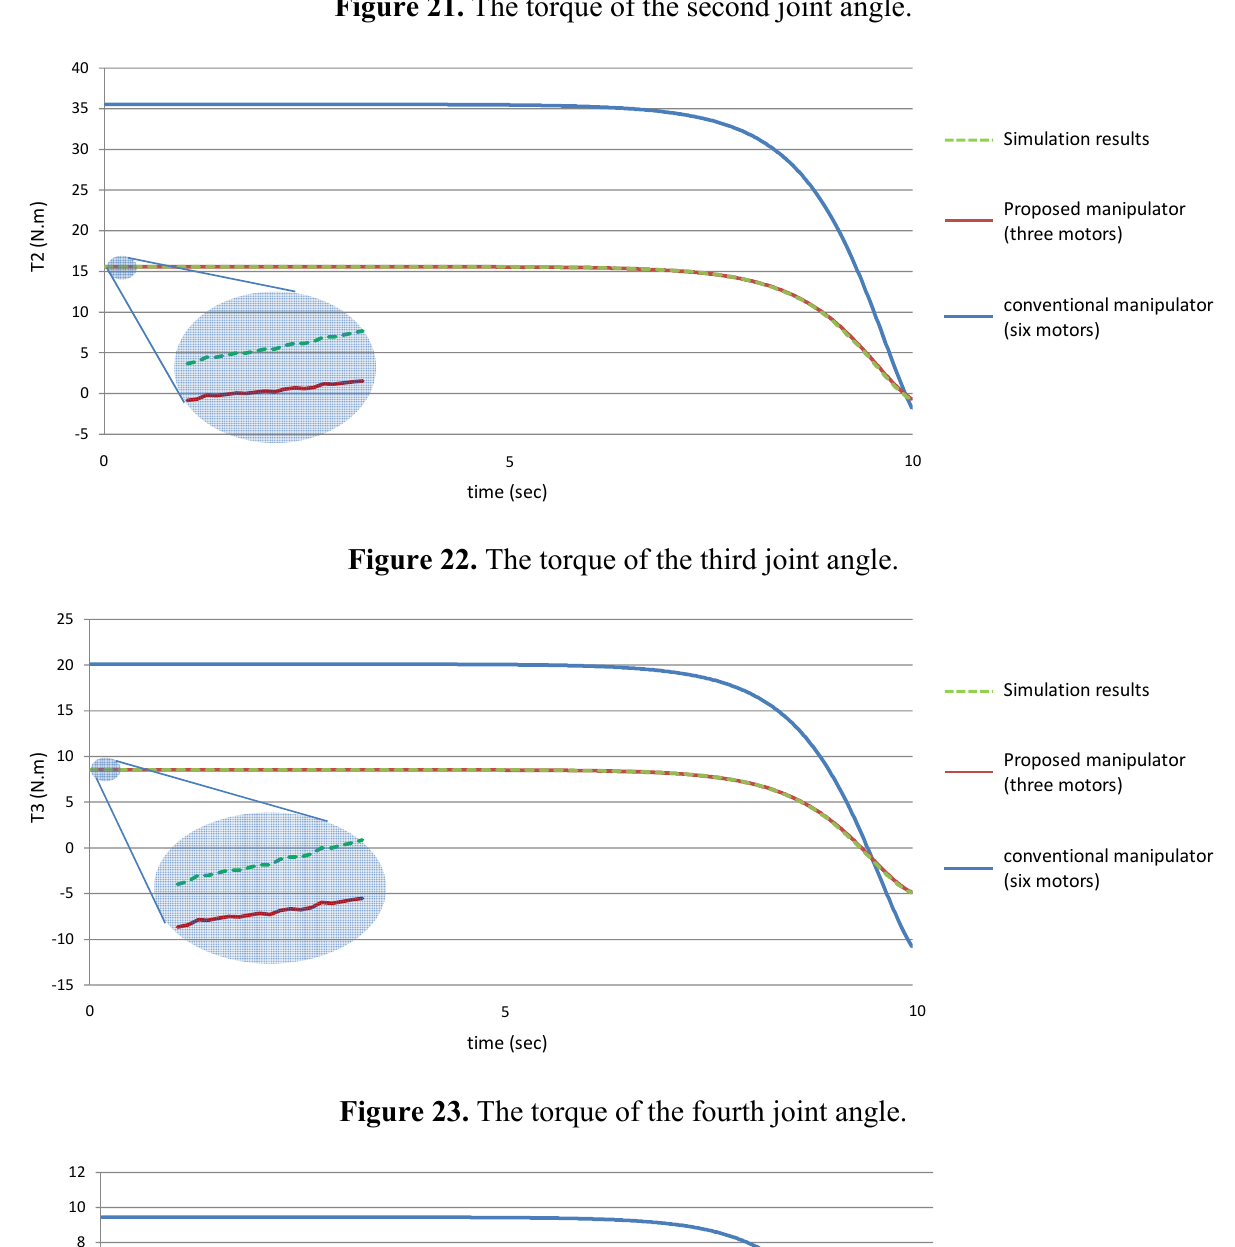
Figure 21. The torque of the second joint angle.